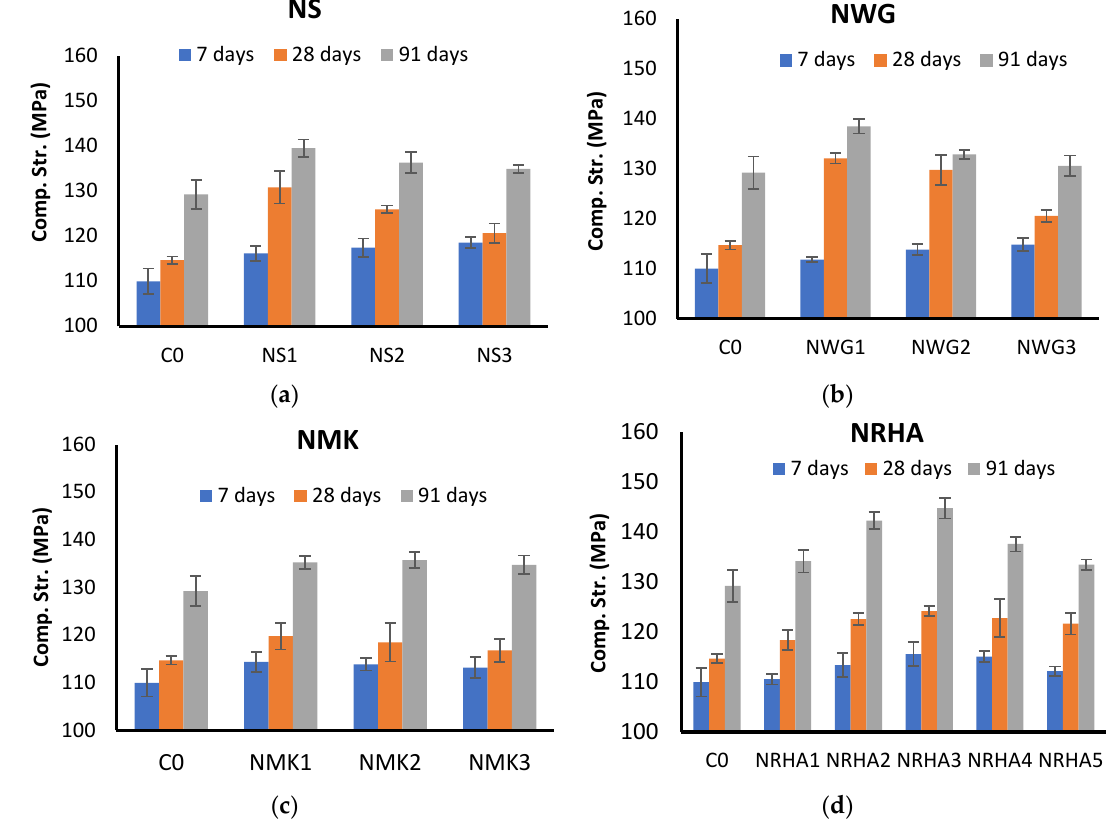
Figure 5. Influence of different nanomaterials on compressive strength of UHPC at 7, 28, and 91 days: ( a ) Nanosilica, ( b ) Nano waste glass, ( c ) Nano metakaolin, ( d ) Nano rice husk ash.